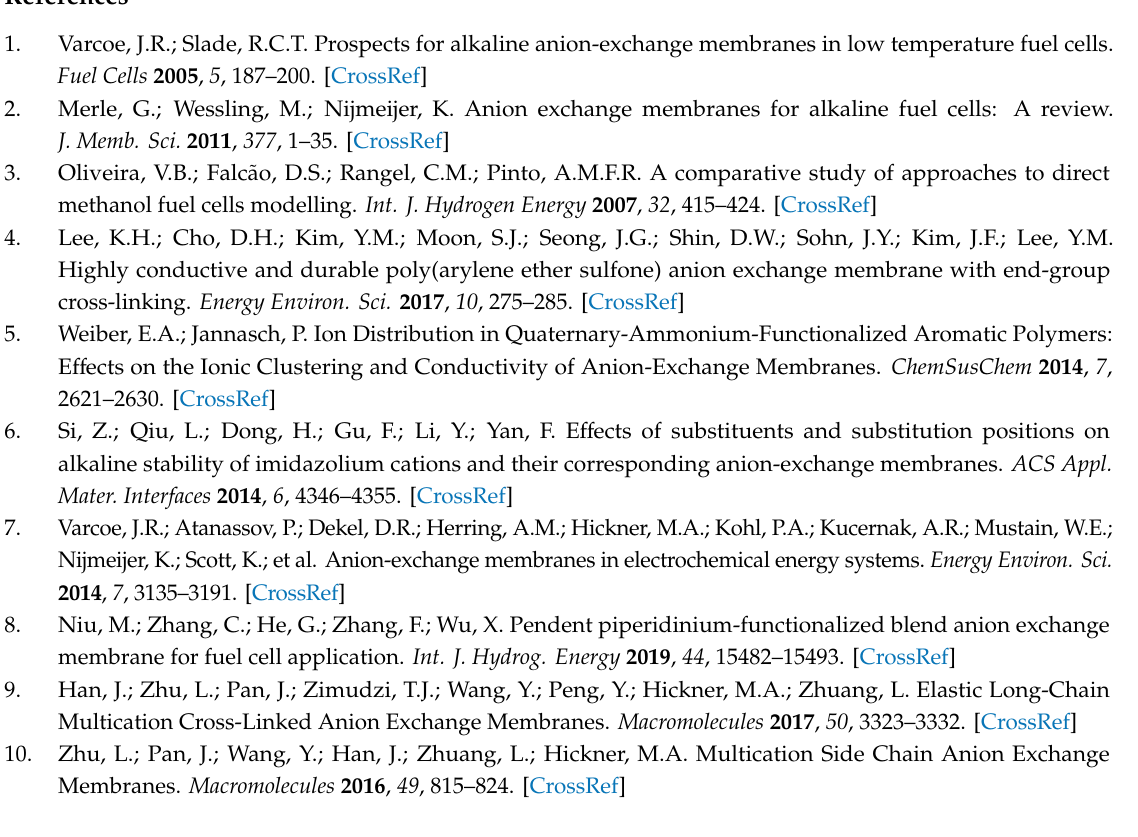
Figure S1: 1 H-NMR spectra of (a) DG, (b) Cel, (c) t-Cel, (d) D-Cel, (e) DG-Cel, (f) PPO, (g) bPPO, and (h) qPPO., Figure S2: SEM images of (a) Cel, (b) t-Cel, (c) D-Cel, and (d) DG-Cel., Figure S3: AFM image of (a,b) qPPO, (c,d) qPPO / D-Cel7, (e,f) qPPO / DG-Cel7., Table S2: Elemental analysis of D-Cel and DG-Cel, Figure S4: E ff ect of cross-linking on composite membranes, Table S3: Comparative data of AEMs, Figure S5: TGA graph of qPPO, qPPO / D-Cel7, and qPPO / DG-Cel7., Table S4: Comparative data of direct urea fuel